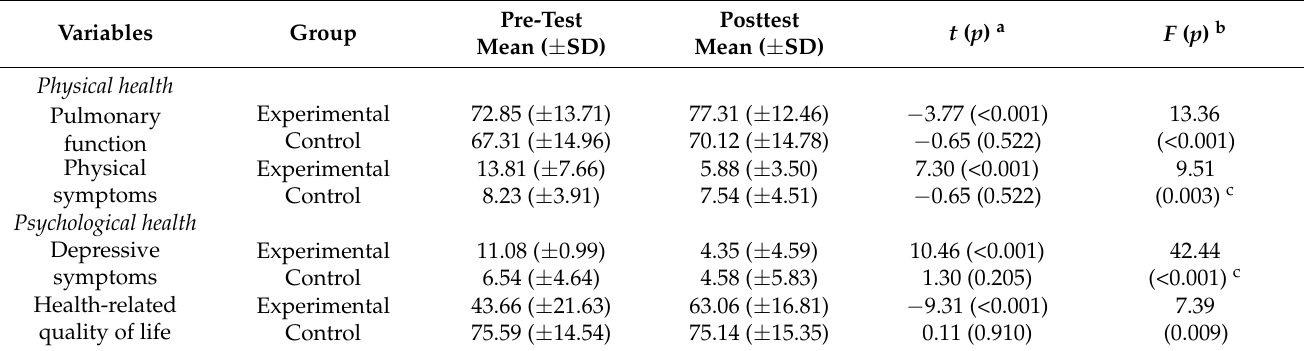
Table 4. Comparison of physical and psychological health between pre- and posttest among experi- mental ( n = 26) and control ( n = 26) groups and group differences in